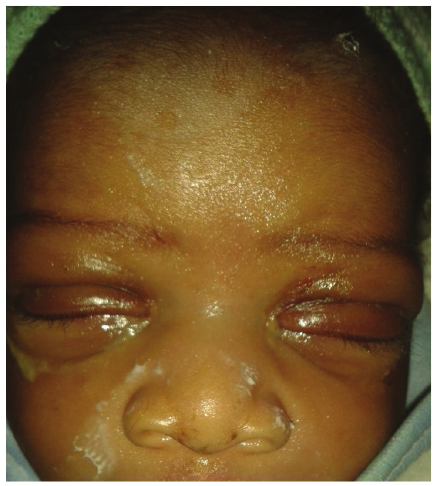
Figure3:Spontaneouslyrevertedeyelidsonday3withmildoedema present.